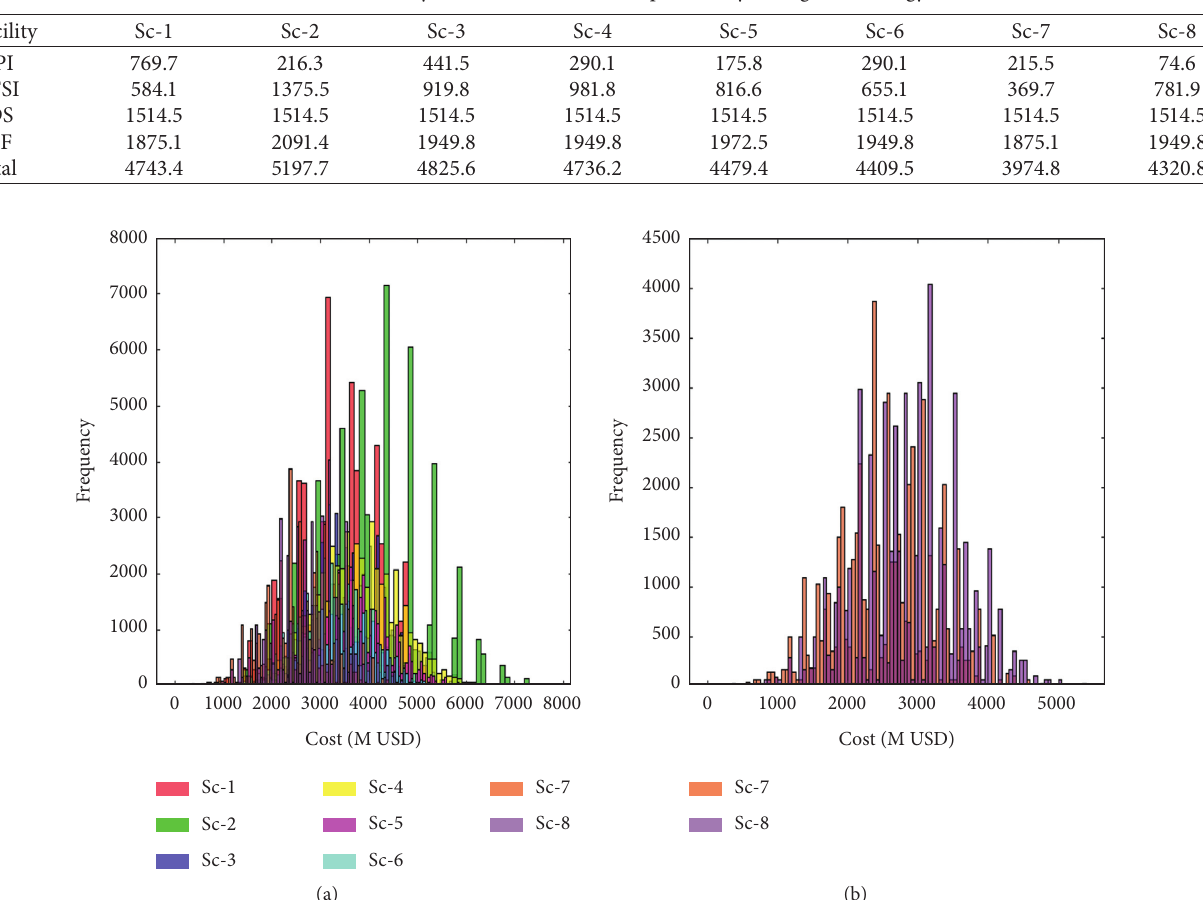
Table 15: Summary of total cost (M USD) per facility storage technology.